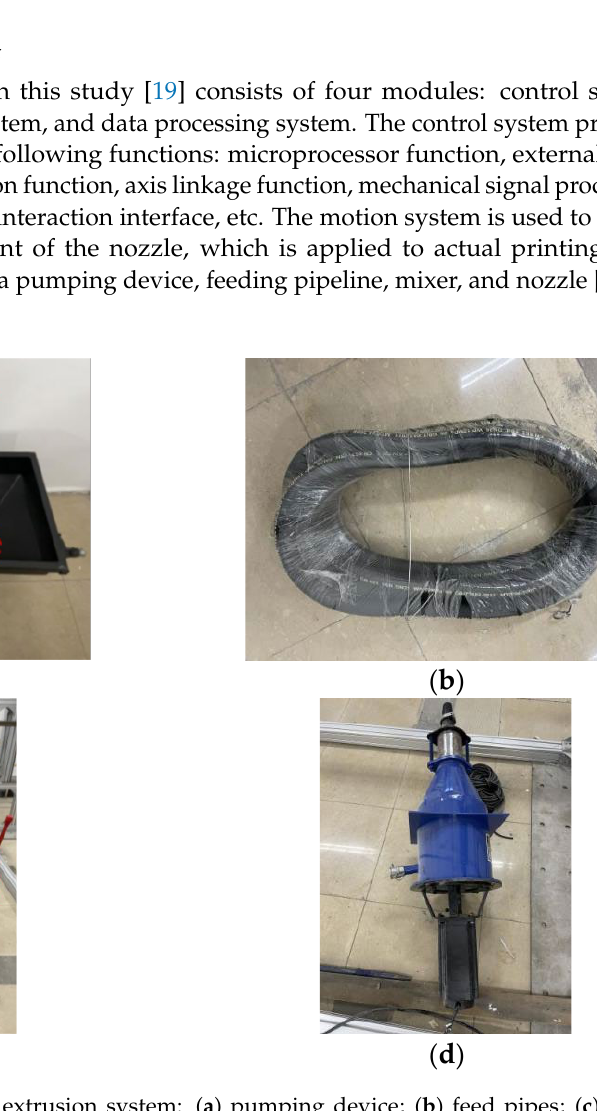
Figure 1. Components of the extrusion system: ( a ) pumping device; ( b ) feed pipes; ( c ) mixer; ( d ) print nozzles.